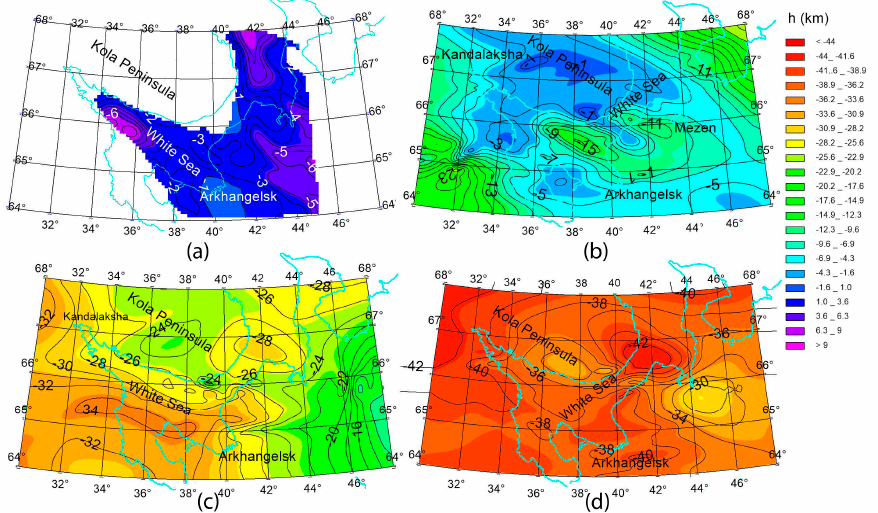
Figure 5. Schemes of the depths of the surfaces K1 ( a ), K2 ( b ), K3 ( c ), and M ( d ).